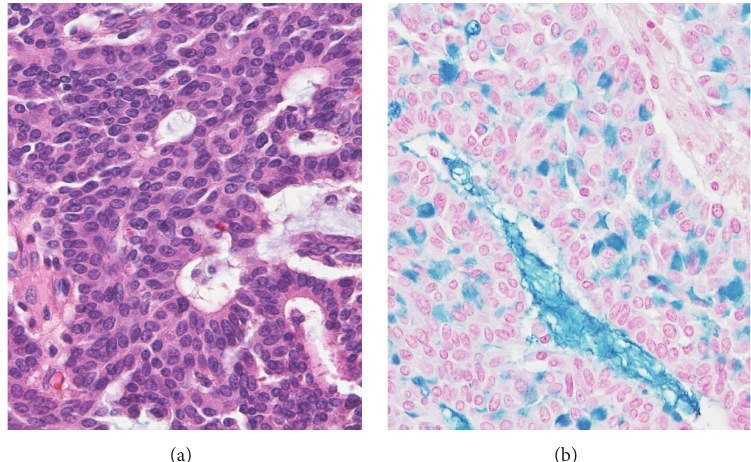
Figure 4: (a) The tumor cells have a round to elongated and hyperchromatic nucleus plus finely granular eosinophilic cytoplasm. In addition, rosette formation is seen (HE stain, original magnification × 400). (b) Intracellular and extracellular mucin deposition (focal distribution) is present (Alcian blue stain, original magnification ×